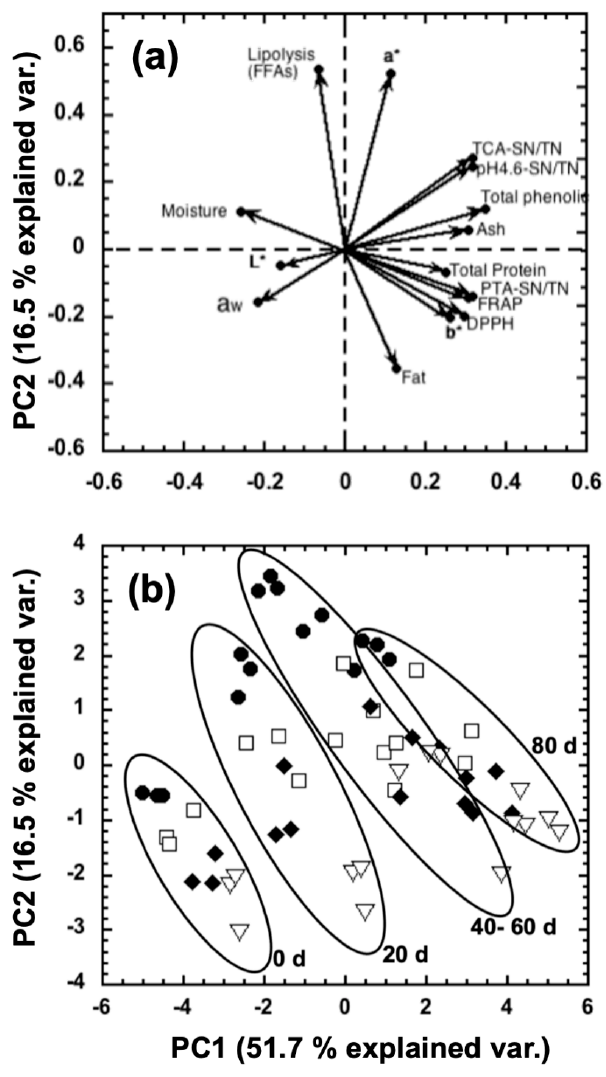
Figure 4. Loading plot ( a ) and score plot ( b ) obtained by principal component analysis (PCA) from different variables of manchego-style cheeses added with bixin 10 ppm ( ), NEC 5 ppm ( ), NEC 7.5 ppm